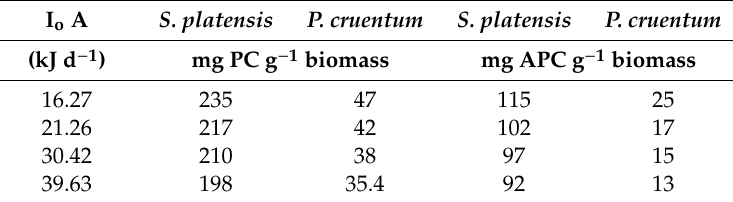
Table 10. PC and APC accumulation in S. platensis and P. cruentum in continuous cultures at di ff erent supplied light